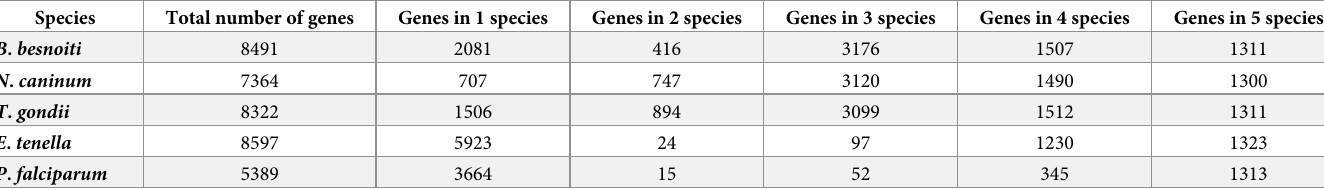
Table 2. Number of genes in